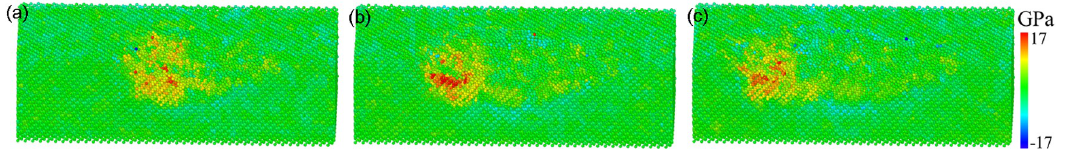
Figure 3. Distribution of hydrostatic pressure under the abrasive ( y > 0) in various scratching stages in the scratching. The sliding distance is ( a ) 5 nm, ( b ) 8 nm, and ( c ) 10 nm. The scratching depth is 1.5 nm.